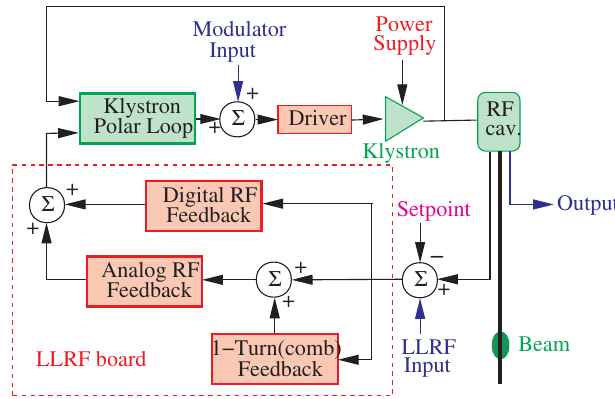
FIG. 2. (Color) Noise sources. Blocks in red represent the major noise sources, in blue are the equivalent noise sources for simulations purposes, and the other components are shown in